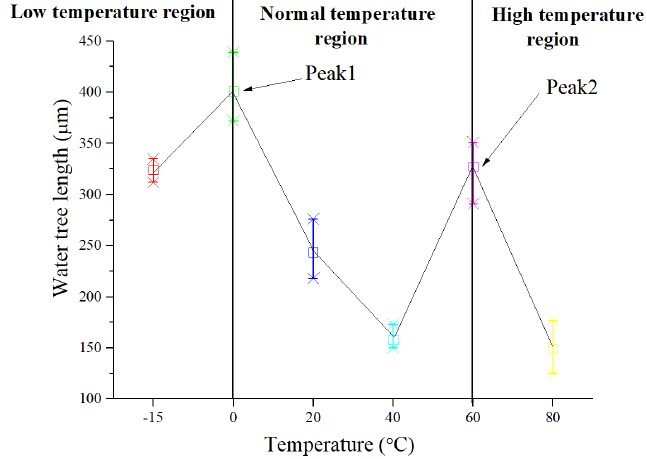
Figure 5. Maximum water tree length at different temperatures.